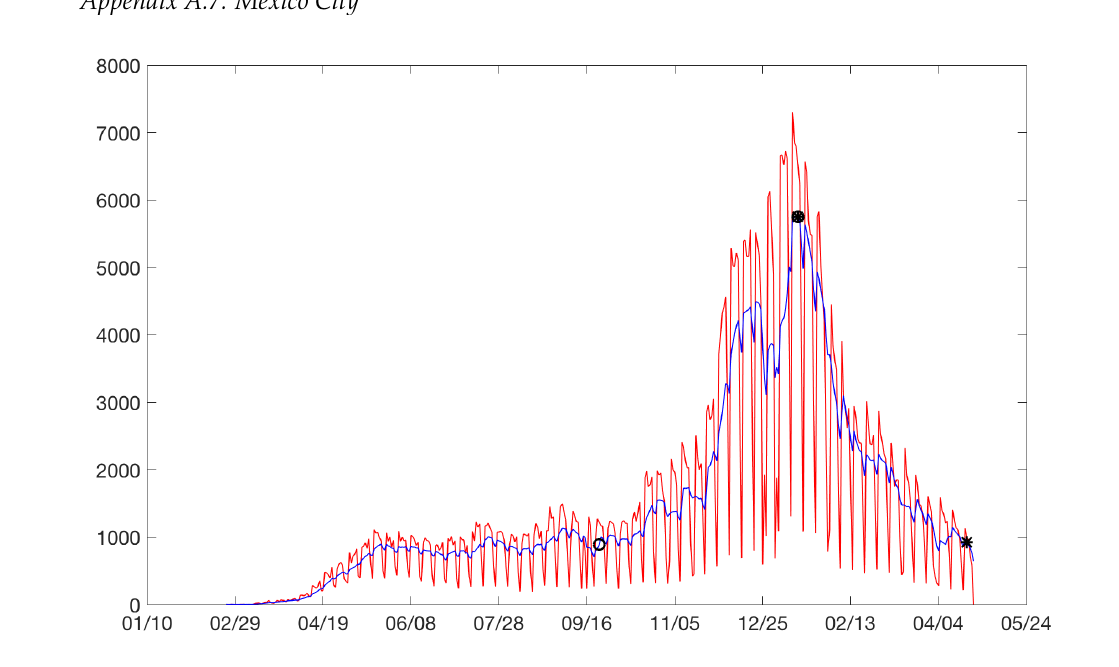
Figure A18. Mexico City: on the horizontal axis is the date in days and on the vertical axis are the daily cases.